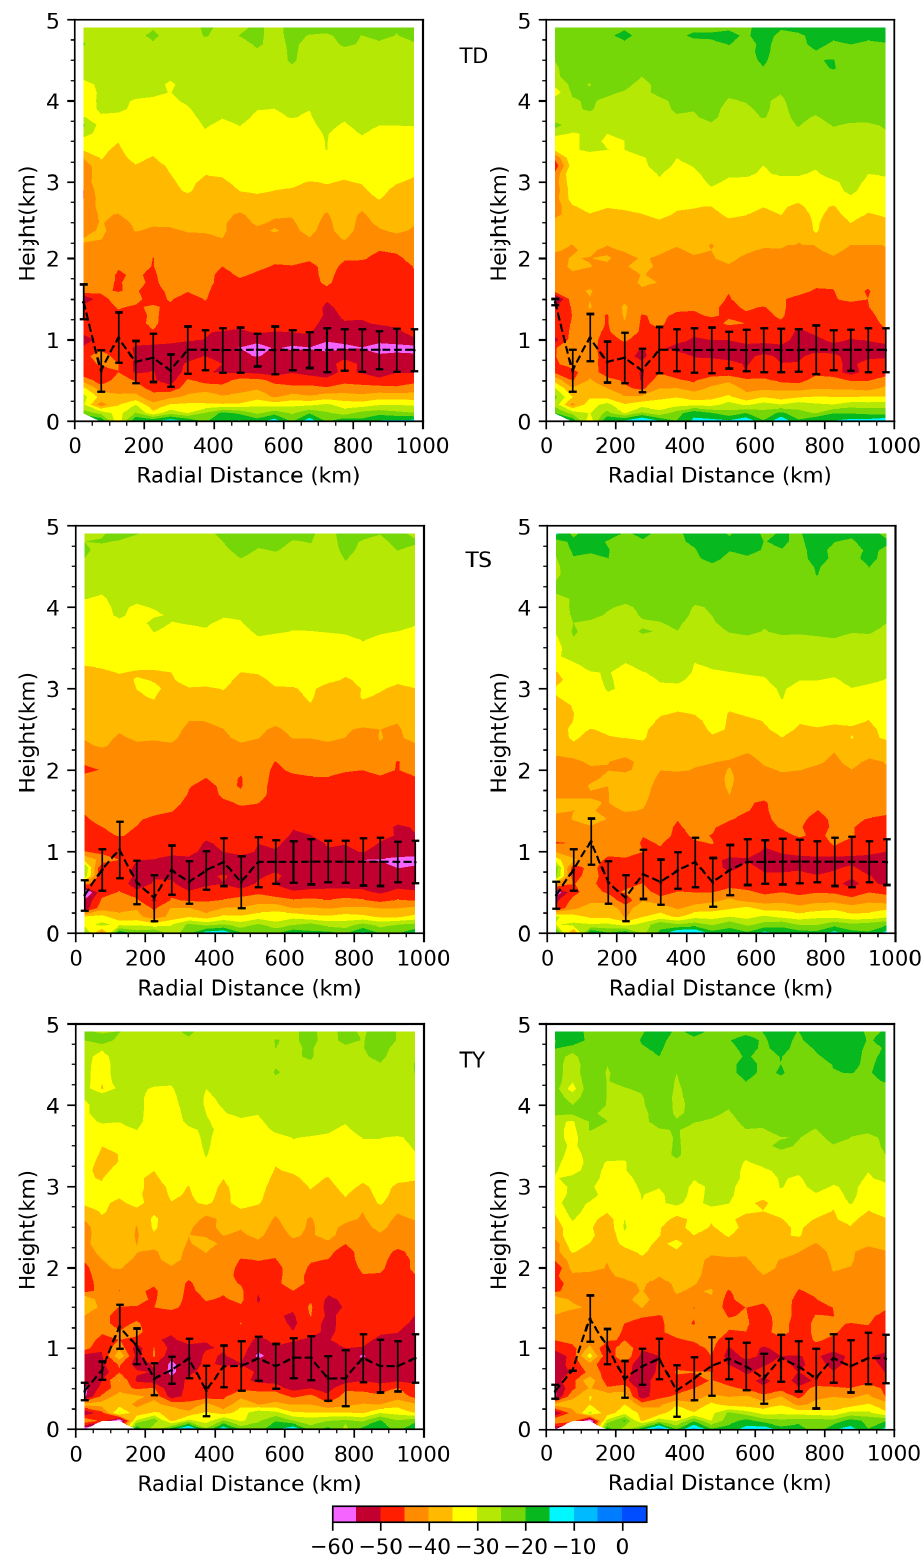
Figure 7. Composite N ( left ) and N i ( right ) vertical gradients cross sections and averages (black dashed lines) and 0.5 times standard deviations (vertical segment, N-unit km − 1 ) of PBLHs calculated by collocated COSMIC-2 ROs data in each 50-km radial distance over the western Pacific. ( top ) TD, ( middle ) TS, and ( bottom ) TY.